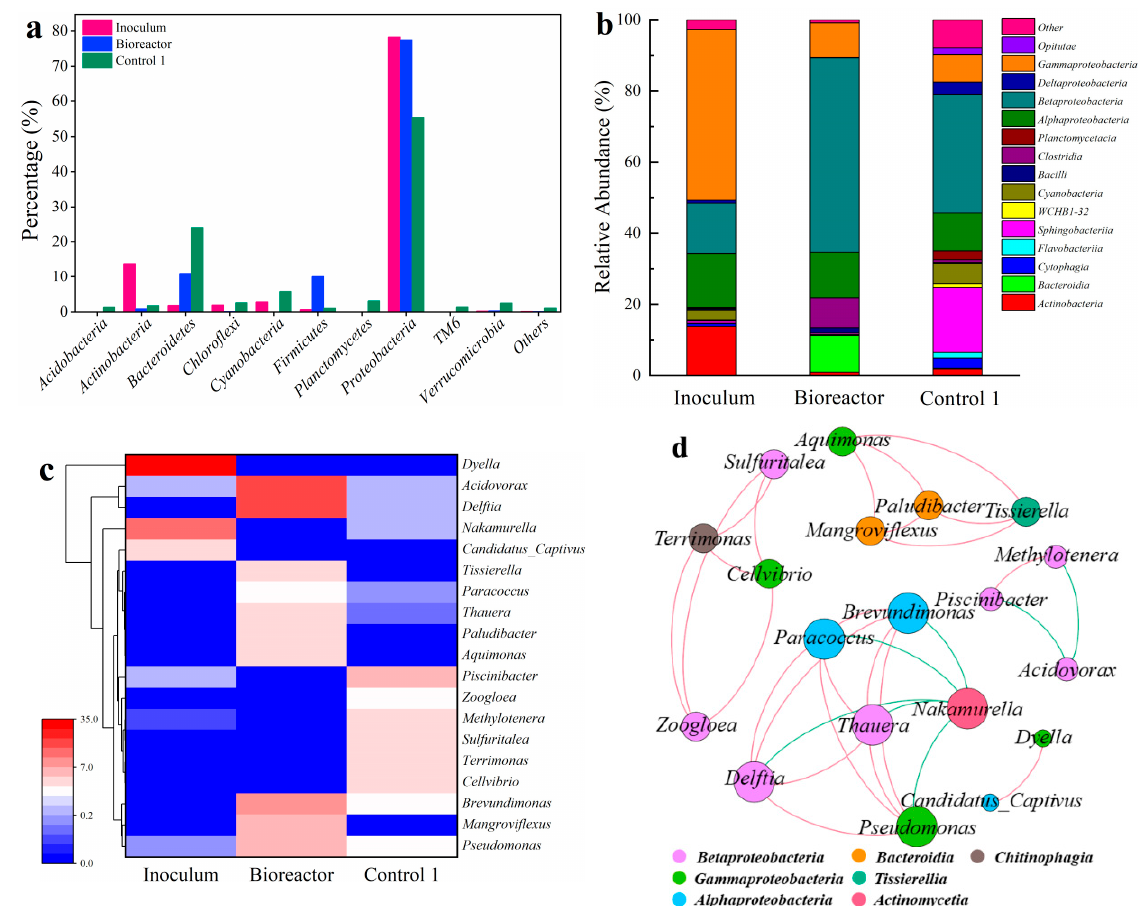
Figure 6. Microbial community composition and interactions. ( a ) The relative abundance of microorganisms at phylum level; ( b ) the relative abundance of microorganisms at class level; ( c ) heatmap of functional microorganisms at genus level; ( d ) co-occurrence network of functional microorganisms; the node represents genus. The size of the node is proportional to the degree of connectivity. Node colors indicate different classes. Positive and negative correlations between nodes were connected by red and green lines, respectively.